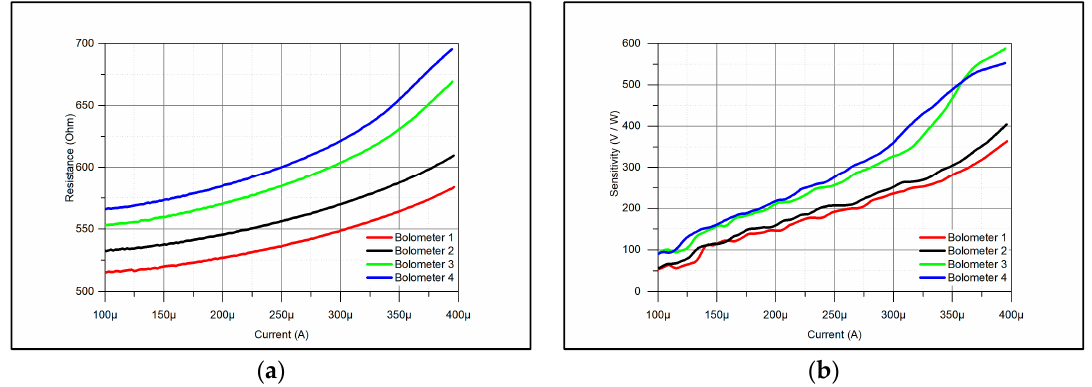
Figure 3. Averaged measurement results: ( a ) resistance; ( b ) sensitivity.